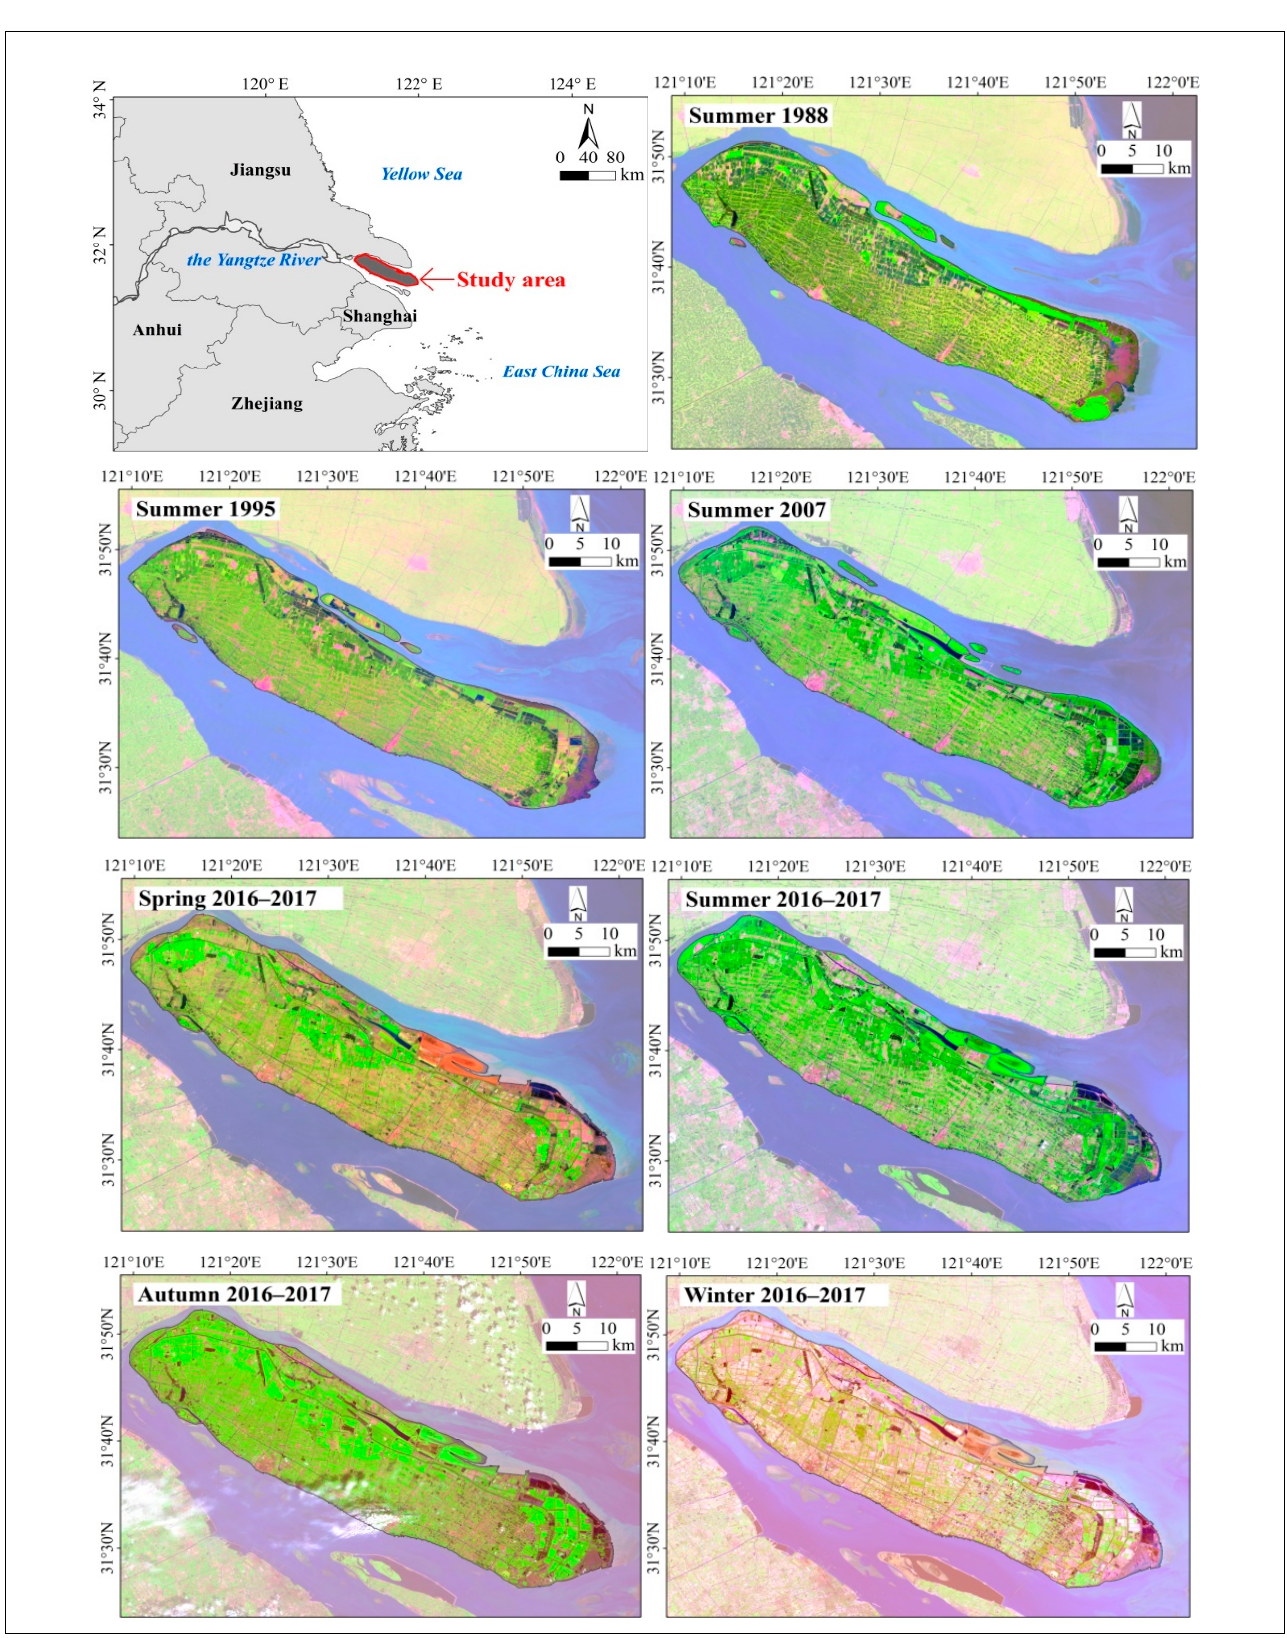
Figure 2. Location, RS images, and outlines of the study area. The outlines in different years and location map were sourced from Chi et al. [59].